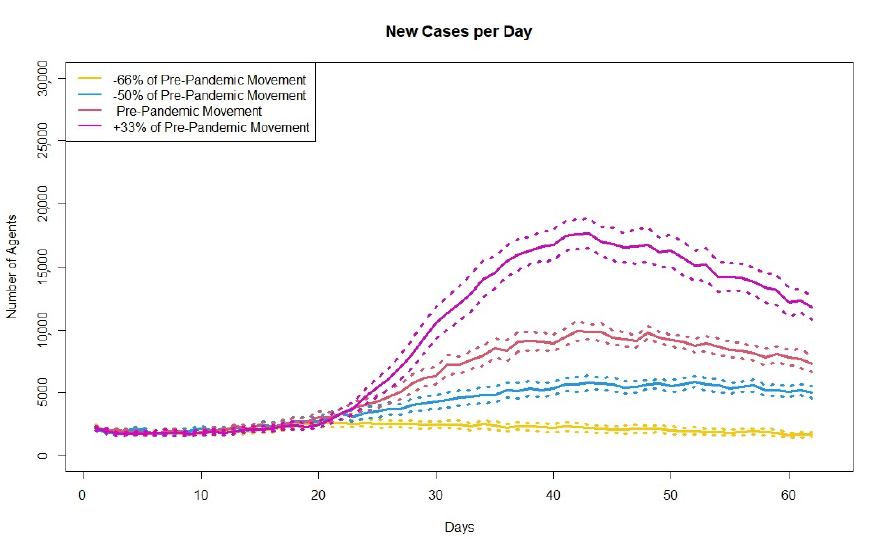
Figure 4. Plot showing the average simulated new cases per day across 30 runs for four different levels of movement. Dashed lines represent upper and lower bound of confidence